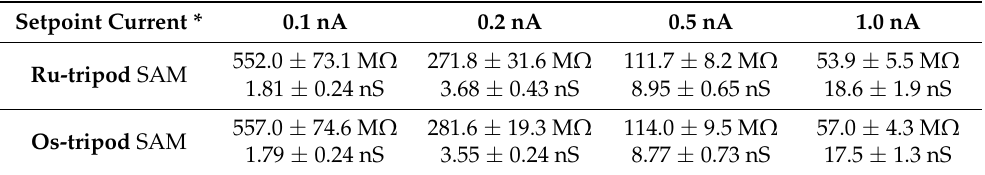
Table 1. Resistance (M Ω ) and conductance (nS) values for Au|SAM systems obtained from I–V curves at different setpoint currents indicated, and at constant bias voltage of 0.05 V. Potential sweep rate was 0.38 V/s.